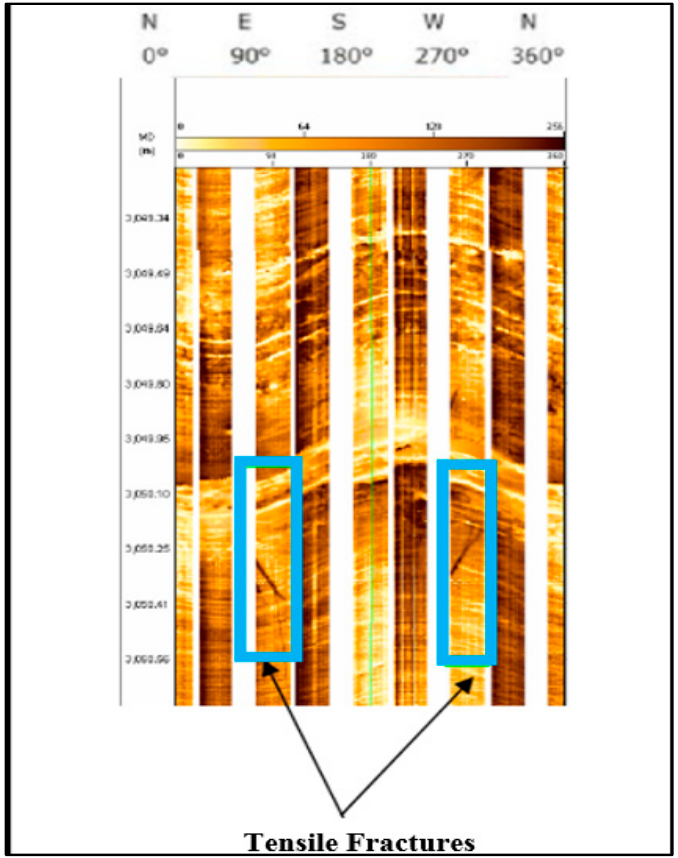
Figure 26. FMI image from Well N-20 with tensile fractures.